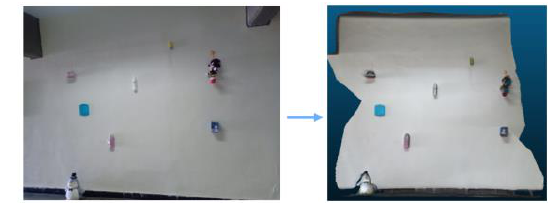
Figure 7. Impact of the use of volumetric objects on the 3D reconstruction of the wall.